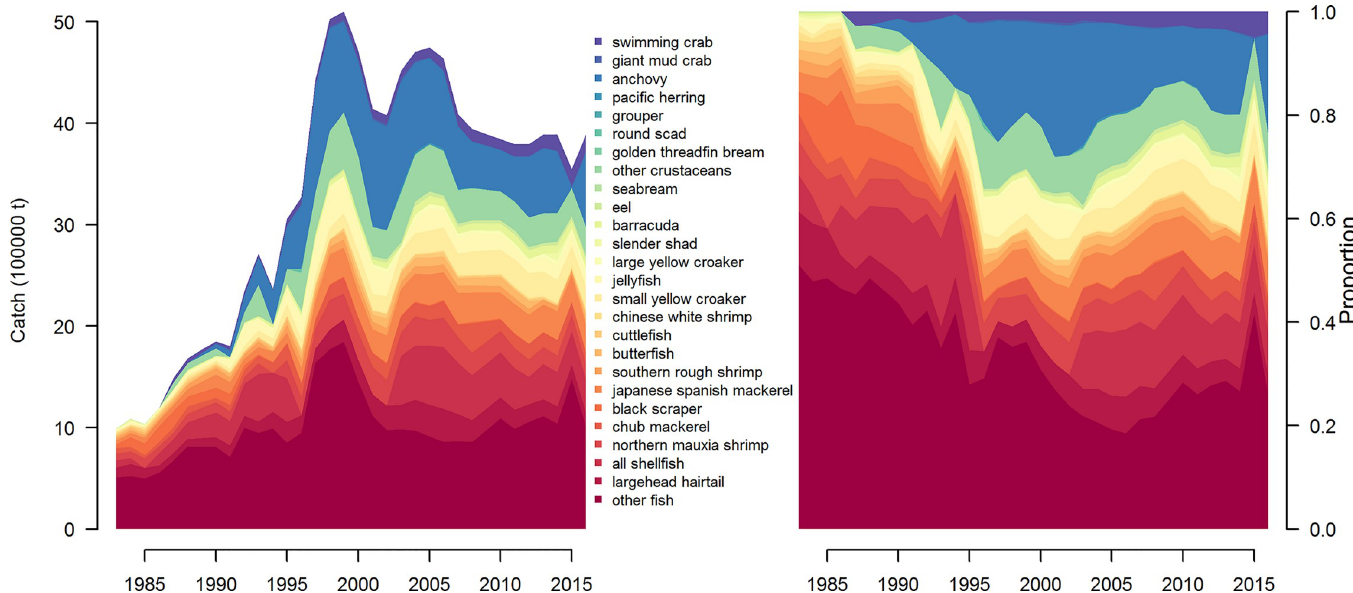
Fig 12. Time series of catch by species/group in the Yellow Sea and Bohai (left) and the proportion of those species within the catch (right). Legend is ordered (increasing from the top) by the proportion of species/group in the catch in the first year of the analysis (1986).